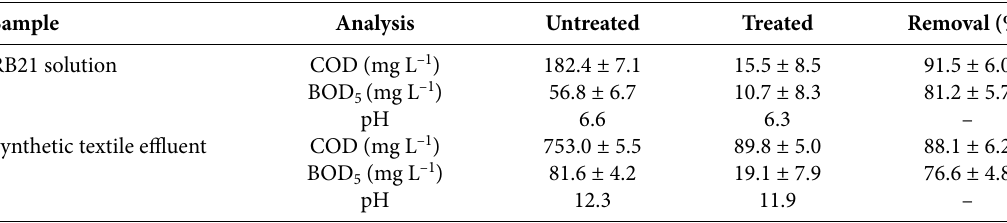
Table 2. COD, BOD 5 , and pH of untreated and treated 50 mg L –1 RB21 solution and synthetic textile effluent by using Co 47.5 / C